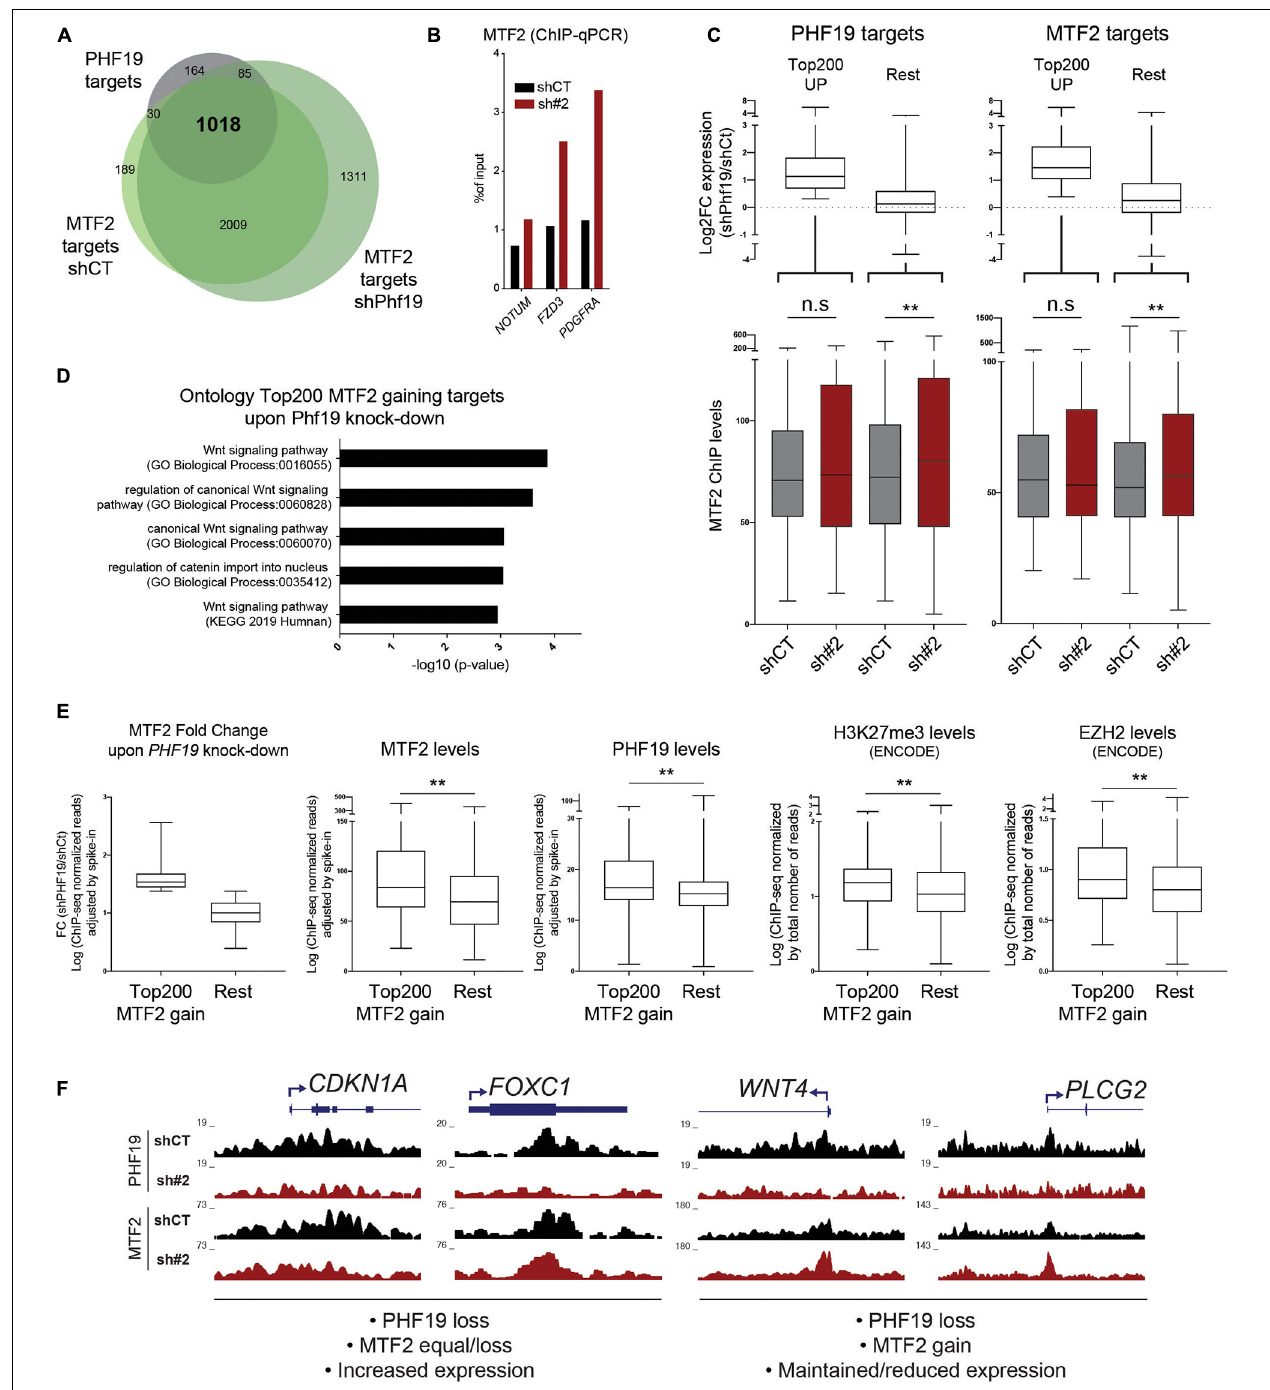
FIGURE 4 | (A) Venn diagram showing the intersection between the PHF19 gene targets and the MTF2 gene targets for cells infected with an empty short hairpin RNA (shRNA, shCT ) and a shRNA against PHF19 ( sh#2 ). (B) MTF2 chromatin immunoprecipitation (ChIP) enrichment (with respect to the input) measured by qPCR of several genes and intergenic region as a negative control in shCT- and sh#2-infected K562 cells. (C) Top : Fold change of sh PHF19 vs. shCT (Log2) of the top 200 upregulated vs. the rest of the PHF19 ( left ) and MTF2 ( right ) gene targets. Bottom : Levels (maximum peak high) of the MTF2 ChIP signal in shCT- and sh#2-infected K562 cells of the top 200 upregulated vs. the rest of the PHF19 ( left ) and MTF2 ( right ) gene targets. (D) Gene ontology of the top 200 MTF2 targets that increase their levels upon PHF19 depletion. (E) Characterization of the top 200 MTF2 targets that increase their levels upon PHF19 depletion versus the rest of the MTF2 levels. From left to right : Fold change of MTF2 gain and levels (maximum peak high) of MTF2, PHF19, H3K27me3, and EZH2. (F) Representative screenshots modified from the UCSC Genome Browser. ∗∗ p < 0 . 01 .